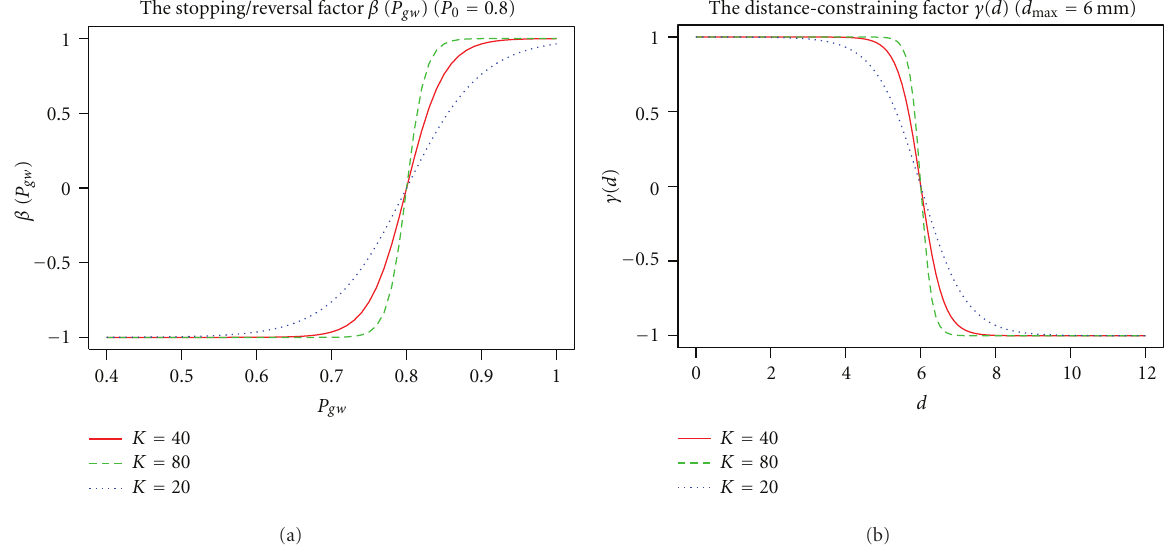
Figure 3: Plots of the stopping/reversal factor β (a) and the distance-constraining factor γ (b) at di ff erent values of the “steepness” constant K (solid red line: default K = 40; dashed green line: K = 80; dotted blue line: K = 20).